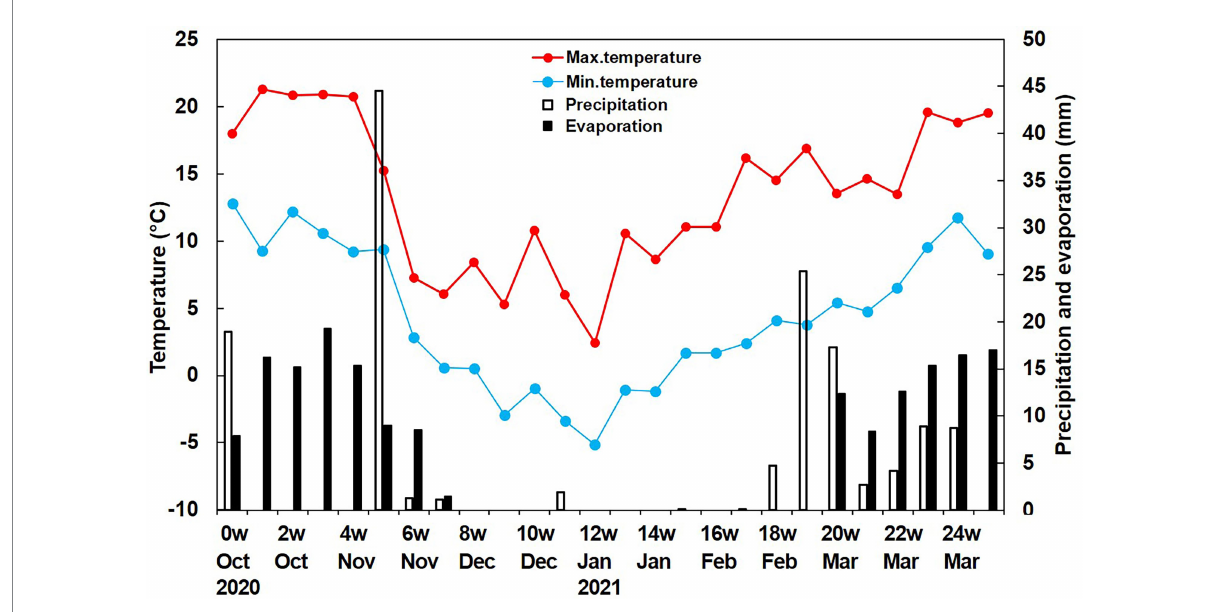
FIGURE 8 Weekly precipitation (rain and snow), evaporation and mean daily minimum and maximum temperatures during the study